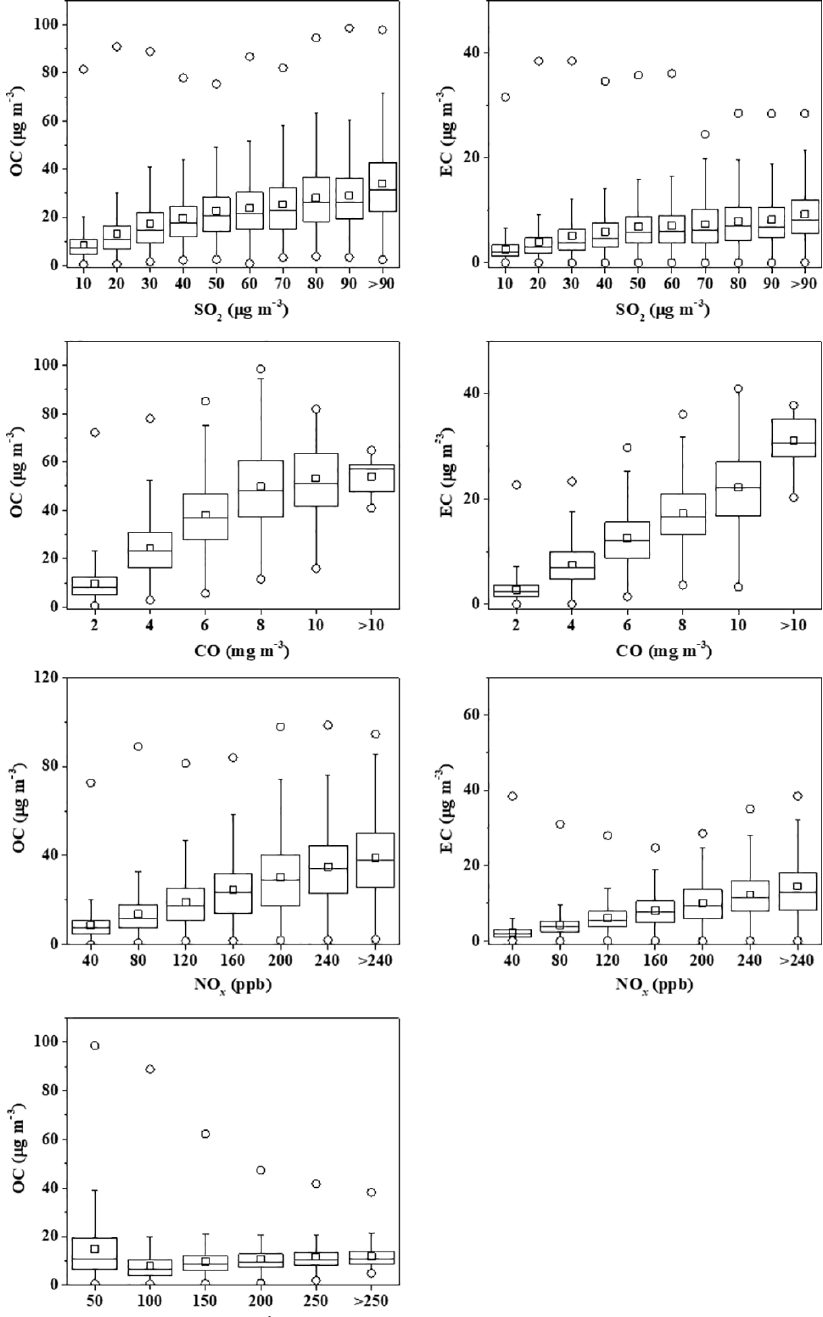
Figure 6. OC and EC concentrations as a function of the SO 2 , CO, NO x , and O 3 concentration.